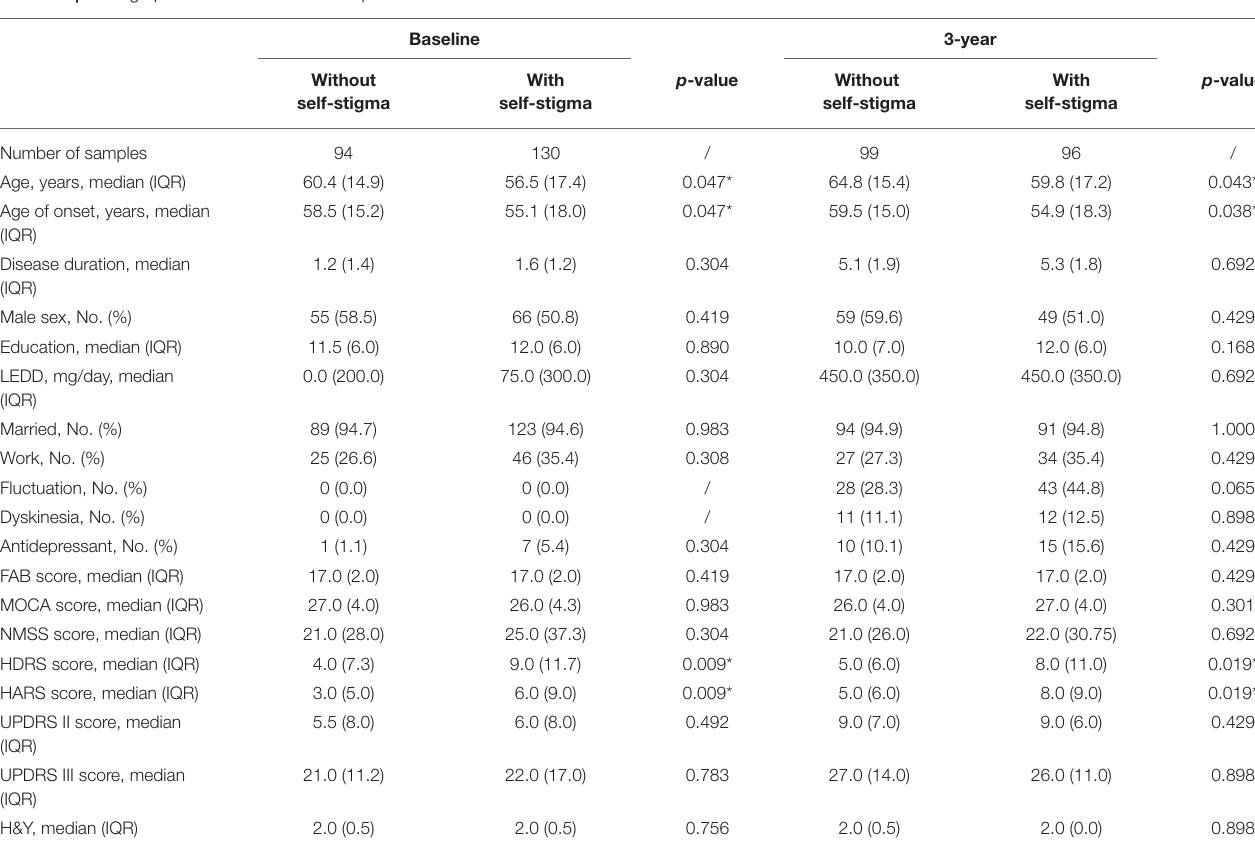
TABLE 1 | Demographic and clinical features of patients with